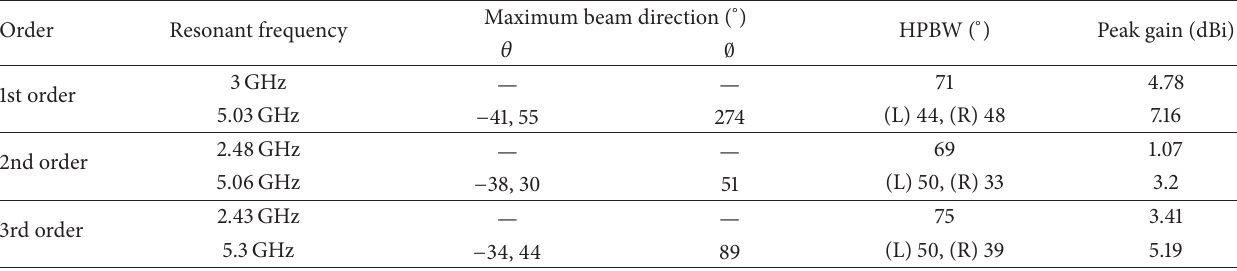
Table 2: Summary of the simulated antennas’ performances.